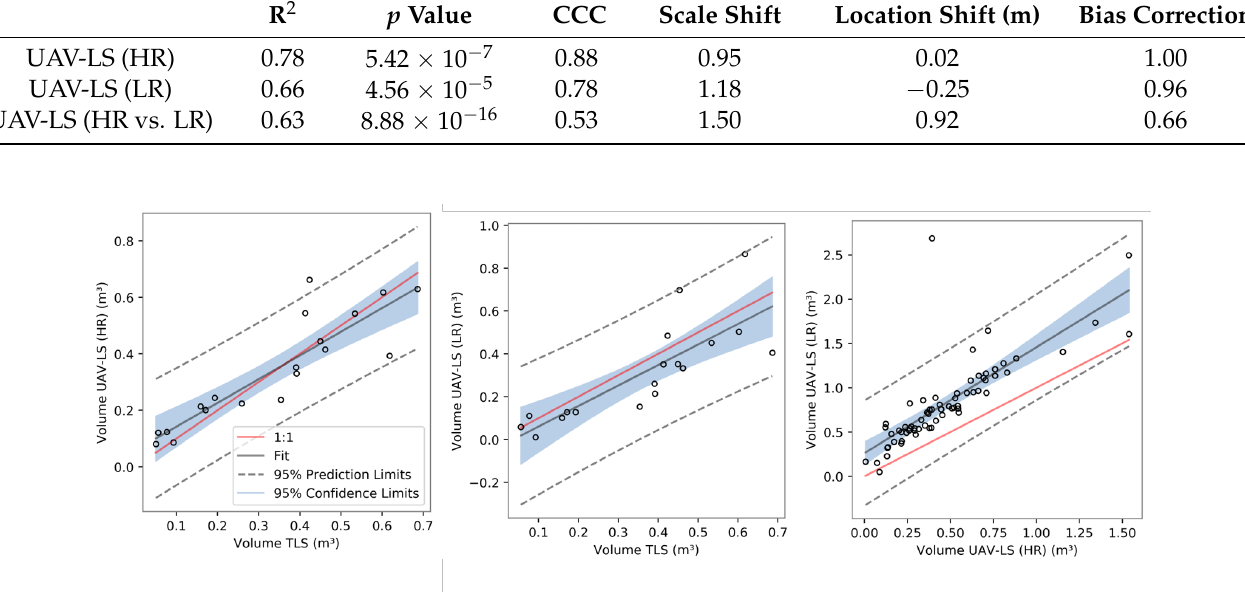
Figure 12. Linear regressions of termite mound volume (raster: 2 cm) for the benchmark data set and the UAV-LS data